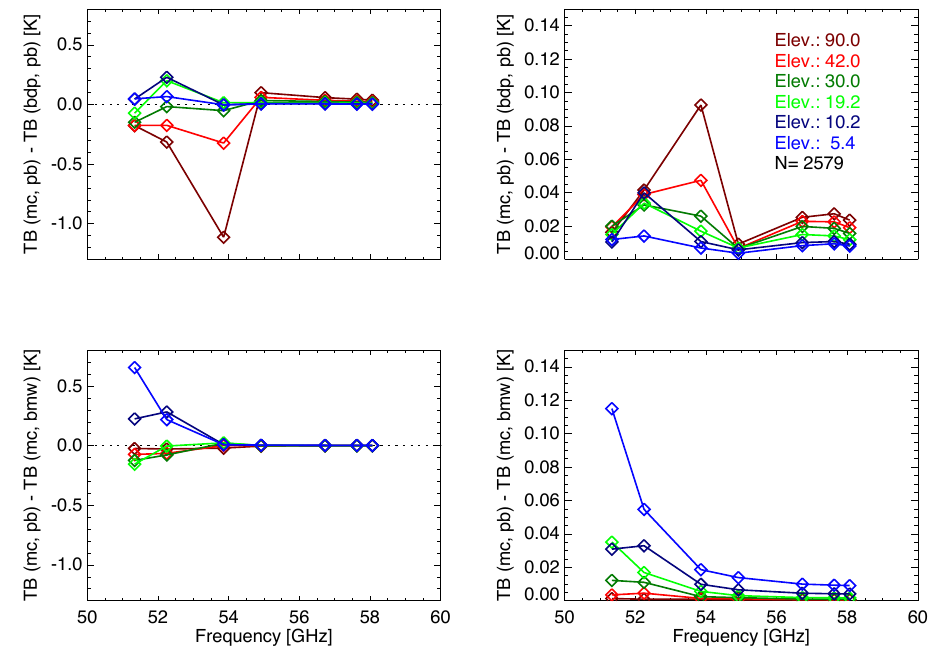
Fig. 4. Differences in simulated TBs: monochromatic (mc), infinitively narrow beam ( pencil beam : pc) assumption minus realistic HATPRO specifications concerning the band pass (bdp) and beam width (bmw). The upper panels show the effects considering band pass characteris- tics, while the lower panels show the effects of actual beam width. Left: systematic differences, right: random differences. The calculations rely on 2579 all-sky radiosonde ascents and are shown for different elevation angles (colored).